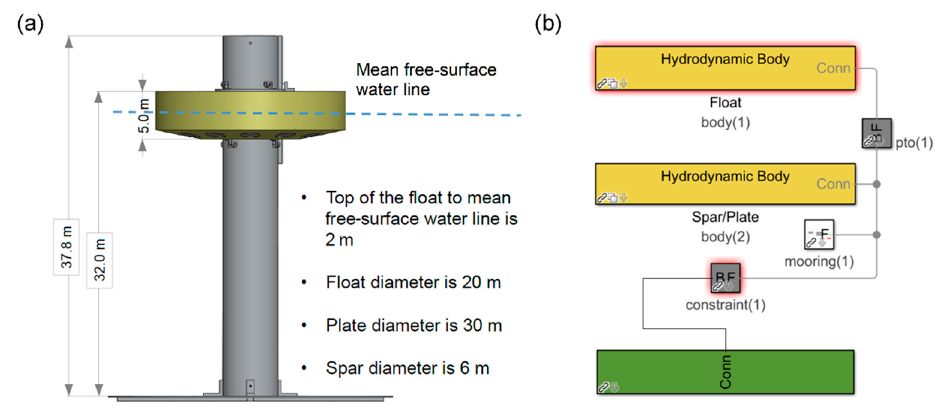
Figure 4 . A representation of ( a ) the two-body FPA WEC device and ( b ) the WEC-Sim model. Table 2. General properties of the two-body floating-point absorber WEC